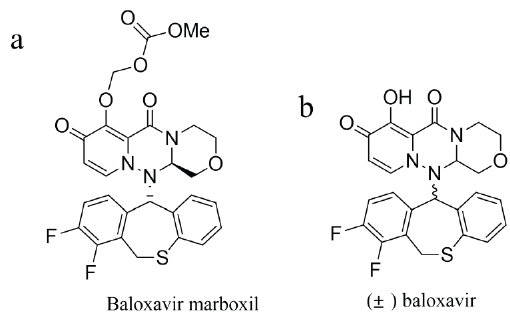
Figure 1. ( a ) Structure of baloxavir marboxil and ( b ) ( ± )-12aR-12-[(11S)-7,8-difluoro-6,11-dihydrodibenzo[b,e]thiepin-11-yl]-7-hydroxy-3,4,12,12a-tetrahydro-1H-[1,4]oxazino[3,4-c]pyrido[2,1-f][1,2,4]triazine-6,8-dione (abbreviated as ( ± ) baloxavir).